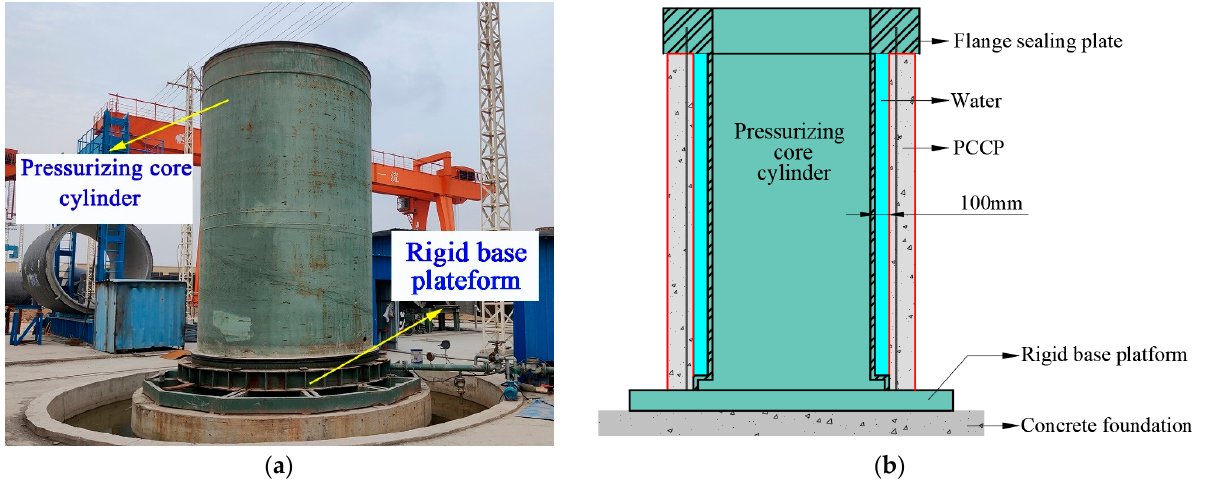
Figure 5. Vertical internal water pressure device: ( a ) pressurizing device; ( b ) cross sectional view of the position of pressurizing device.